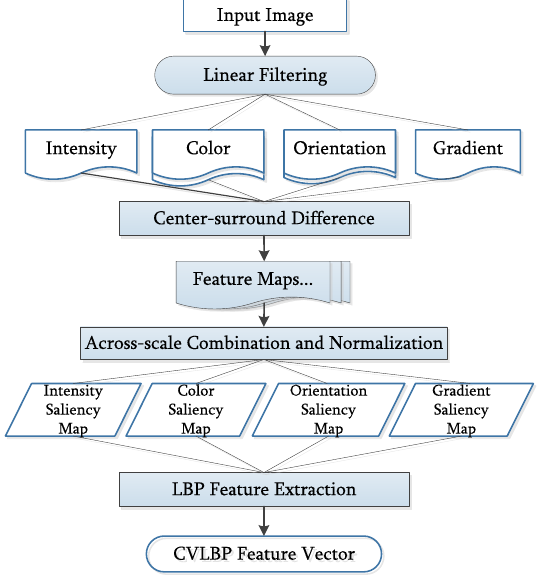
Figure 3. Feature extraction using CVLBP model